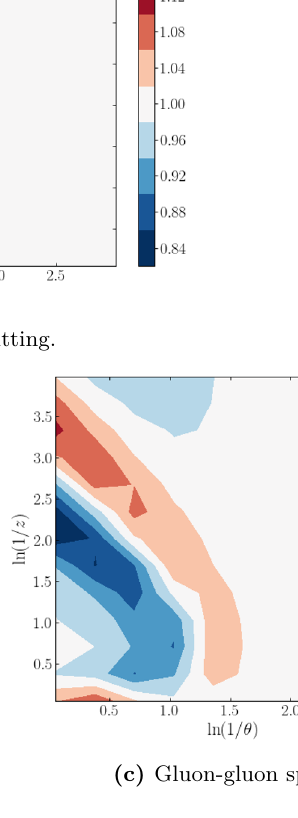
Figure 4. The ratio F med ( z, θ ) | large − N and z with L = 2 fm and E = 100